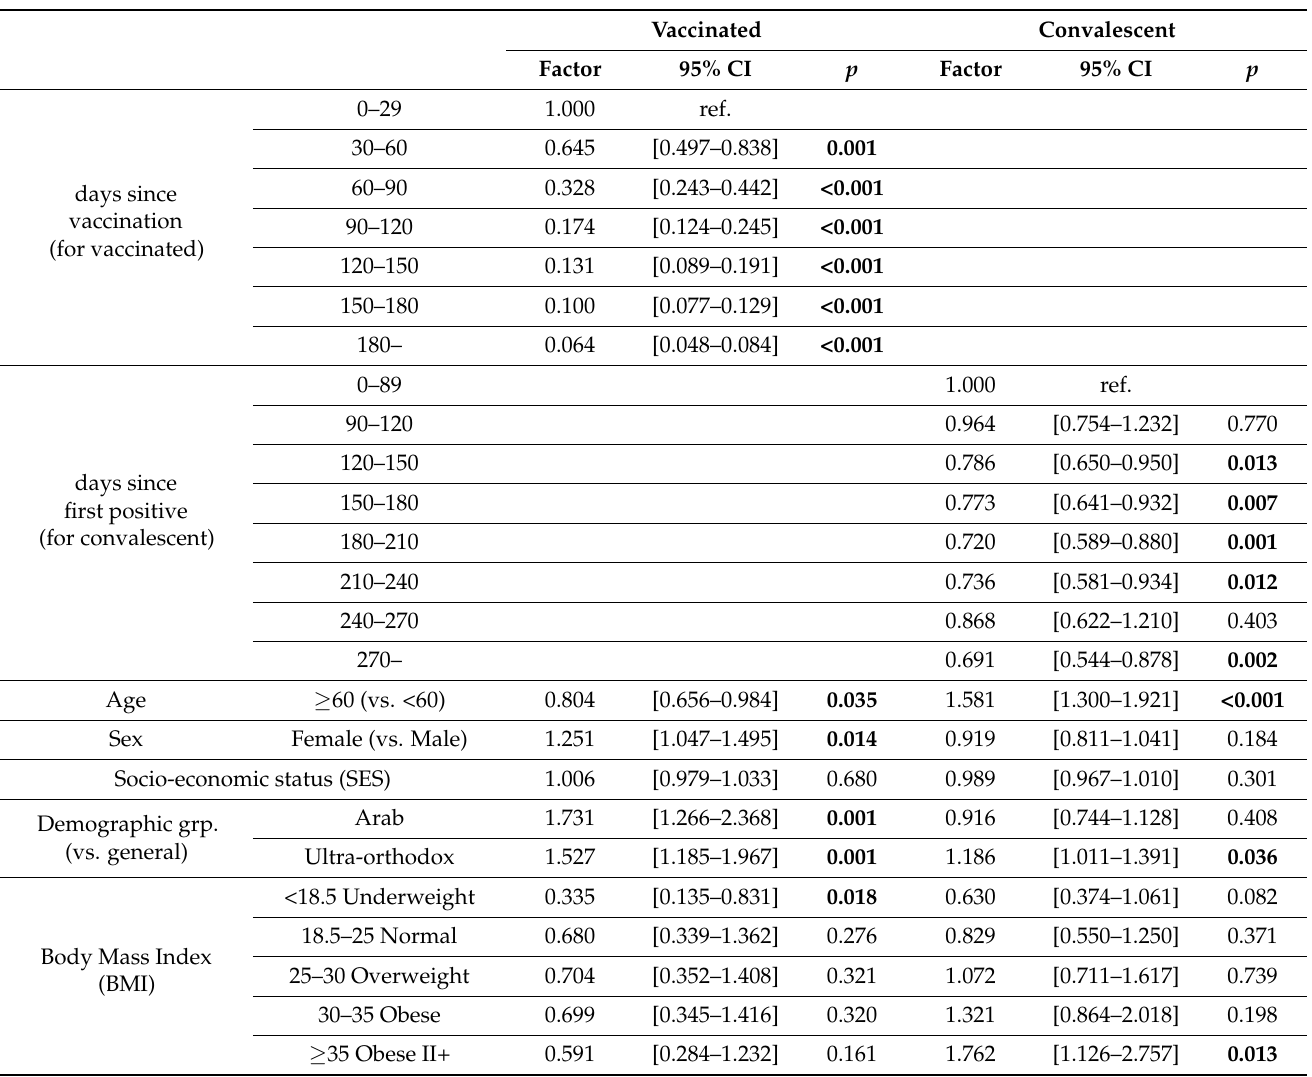
Table 5. Linear regression models of SARS-CoV-2 IgG antibody titer according to days intervals. Regression coefficients were obtained by fitting a multivariable linear regression model for the log of antibody titer. Comorbidity covariates, same as those displayed in Table 4, were included in the regression. Significant p -values are shown in bold